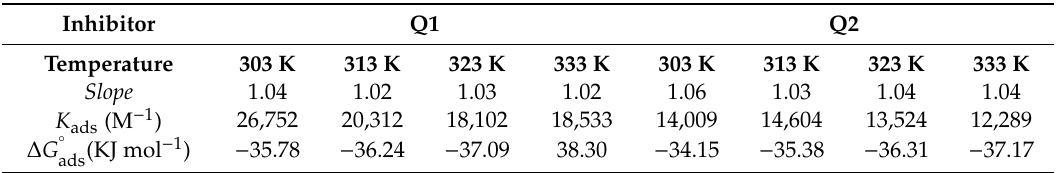
Table 4. The adsorption parameters for the corrosion of MS in inhibited solutions at di ff erent temperatures. Inhibitor Q1